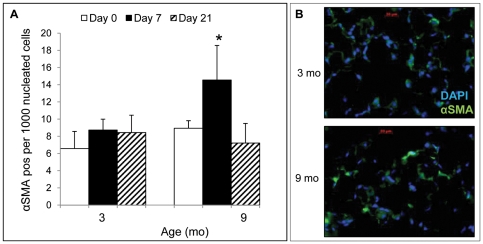
Enumeration of aSMA-positive cells after PNX in 9 vs 3 month mice.
A. Number of αSMA-positive cells (per 1000 nucleated cells) 0, 7 and 21 days post-PNX in 3 and 9 month mice. Data are mean values ± SEM. *P<0.05 between Day 7 and Day 0; B. Micrograph illustrating the difference in αSMA-positive cell abundance in the lung parenchyma at day 7 post-PNX in 3 and 9 month mice. Photomicrograph (400× magnification) with αSMA (green) and DAPI nuclei (blue).